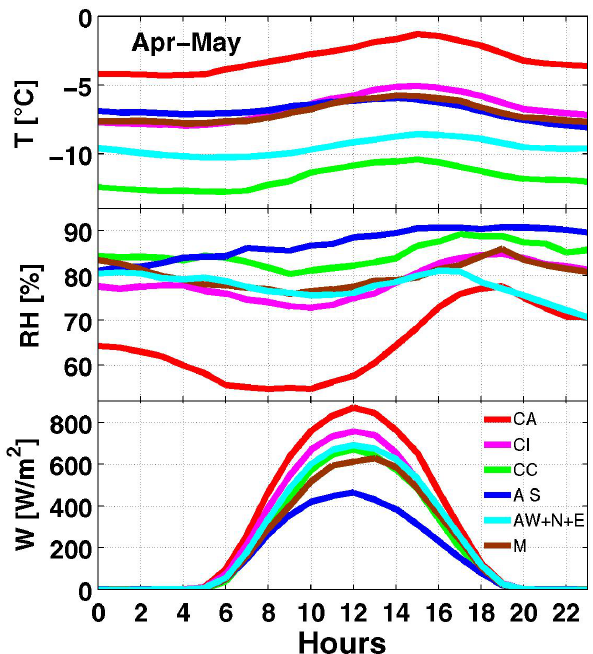
Fig. 4. Mean 1995–2008 diurnal cycles of the temperature, the rela- tive humidity percentage RH and the global short wave radiation W for the April–May period as a function of SYNALP weather types.